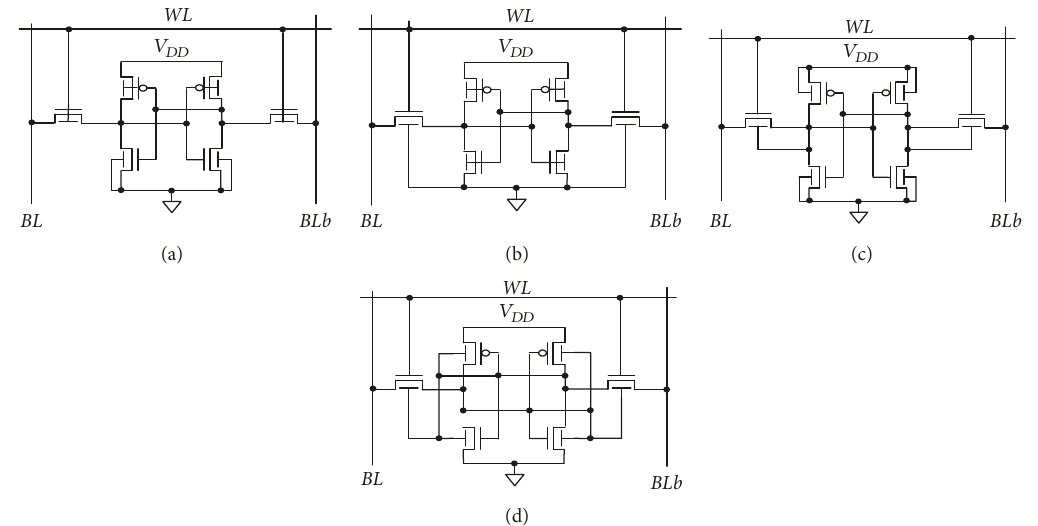
Figure 8: Reproduced from H. Yang et al. (2017) (under the Creative Commons Attribution License/public domain).